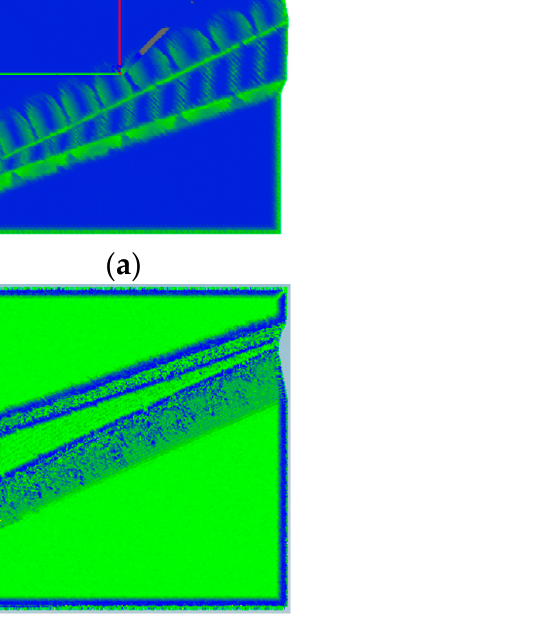
Figure 12. Visualization of the transition surface with variable curvature ( a ) speed visualization before optimization ( b ) speed visualization after optimization ( c ) acceleration visualization before optimization ( d ) acceleration visualization after optimization.